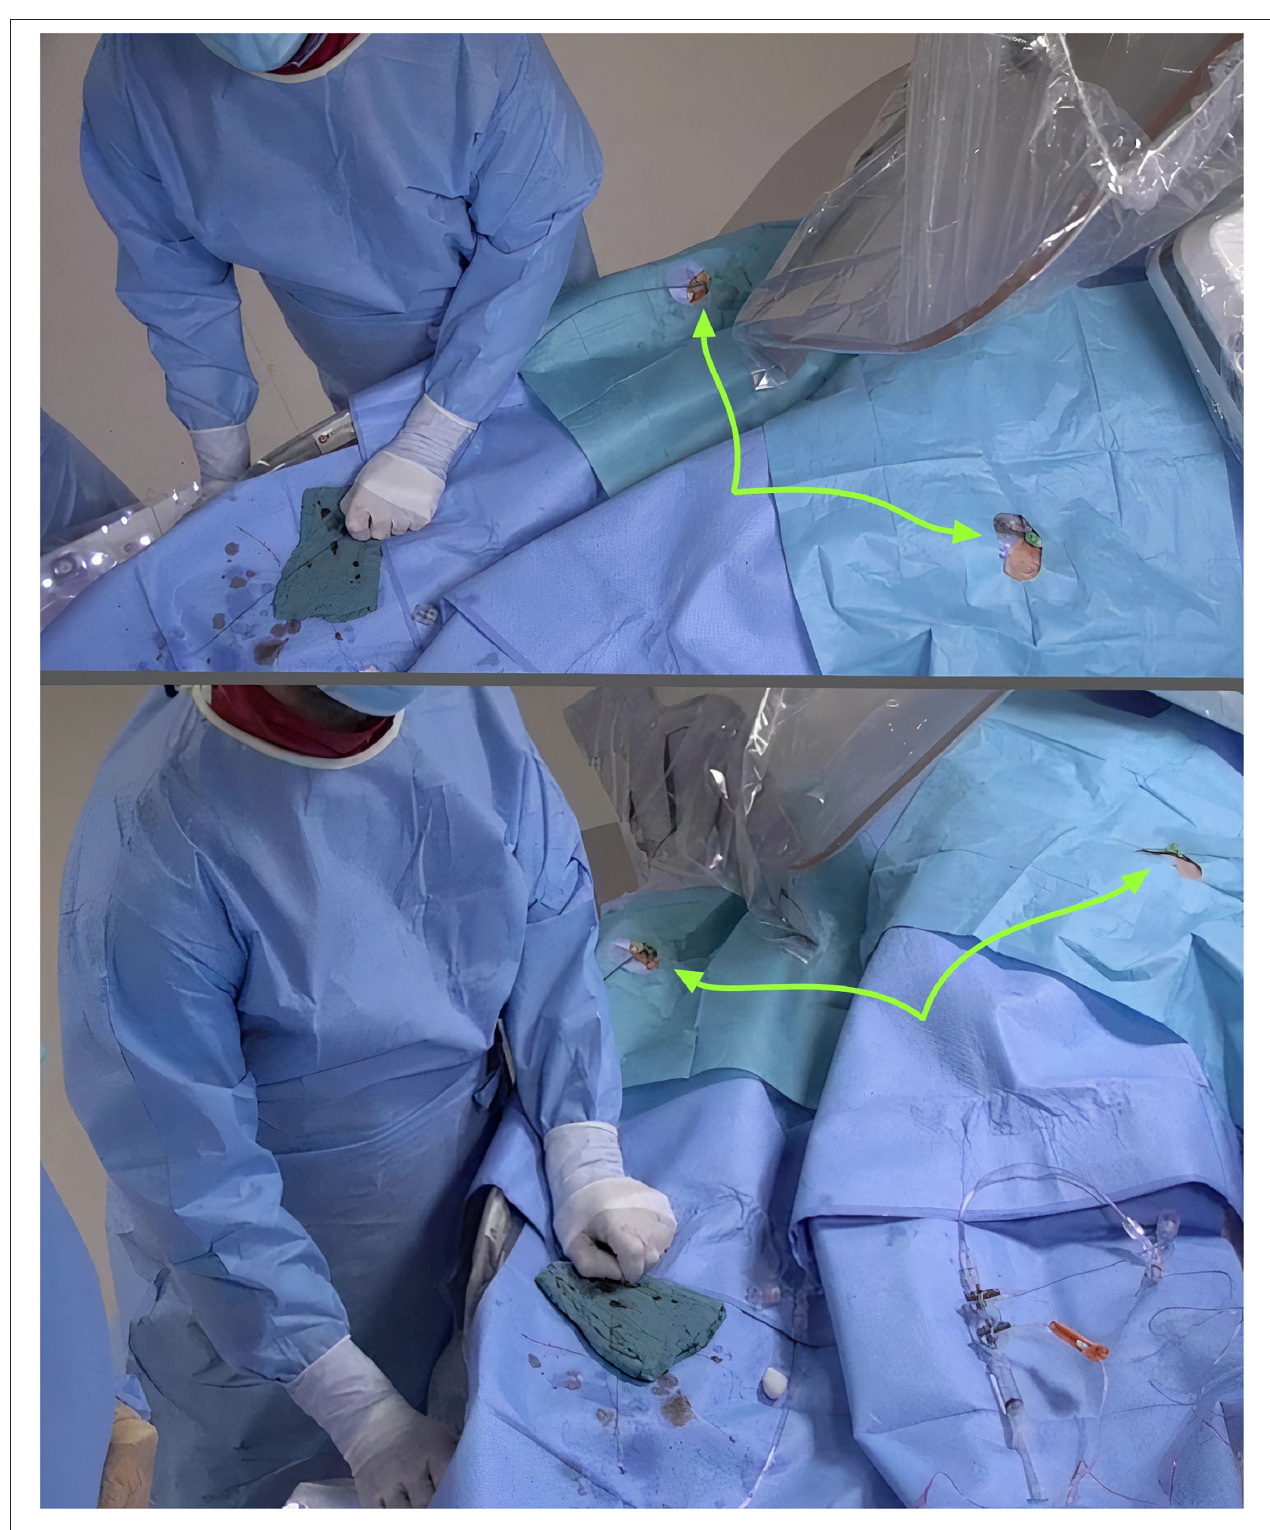
FIGURE 3 | Improved ergonomics during dual distal radial (arrows) in CTO PCI.